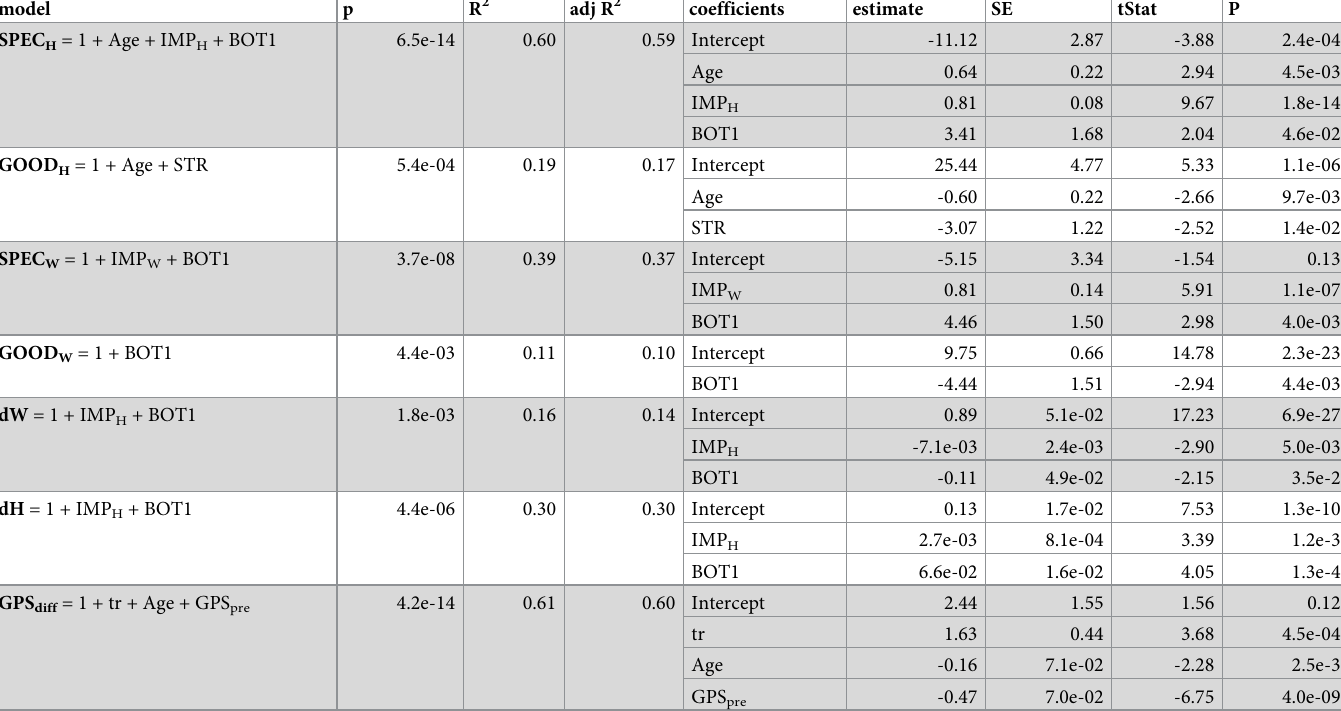
Table 2. Results from the stepwise regression analysis. For detailed explanation cfr. Matlab documentation for function ‘fitlm’. We considered the following dependent variables. SPEC W : specificity of reconstruction (VAF POST − VAF TD ) relative to the weight optimization method, (% VAF). GOOD W : goodness of reconstruction (VAF PRE − - VAF POST ) relative to the weight optimization method, (% VAF). SPEC H : specificity of reconstruction relative to the activation optimization method, (% VAF). GOOD H : goodness of reconstruction relative to the activation optimization method, (% VAF). dW : change in muscle synergies vectors of weights after the treatment, (correlation coefficient between pre- and post-treatment synergy weights). dH : change in muscle synergies activation profiles after the treatment, (RMSE between pre- and post-treat- ment synergy activations). GPS diff : change in Gait Profile Score after the treatment, (degrees). The independent variables are the following. tr : Treatment administered to the patient, (BOTOX/SEMLS). dT : time between pre- and post-treatment gait analysis, (days). Age : age of the patient at the time of surgery, (years). IMP W : impairment of the patient measured in the pre-treatment condition. (VAF PRE − VAF TD ) relative to the weight optimization method, (% VAF). IMP H : impairment of the patient measured in the pre-treatment condition relative to the activation optimization method, (% VAF). SPA : spasticity score measured in the pre-treatment clinical examination. STR : strength score measured in the pre-treatment clinical examination. SEL : selectivity score measured in the pre-treatment clinical examination. GPS pre : Gait Profile Score computed in the pre-treatment gait analysis, (degrees). BOTOX 1-5 : botulinum injection site. 1-rectus femoris, 2-biceps femoris, 3-medial hamstrings, 4-gastrocnemius, 5-soleus,